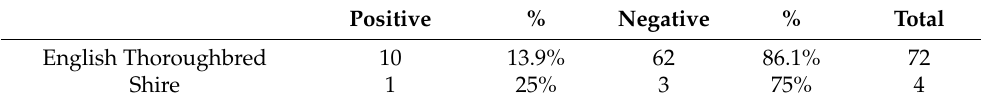
Table 3. EcPV9 genoprevalence detected in English Thoroughbred and Shire.